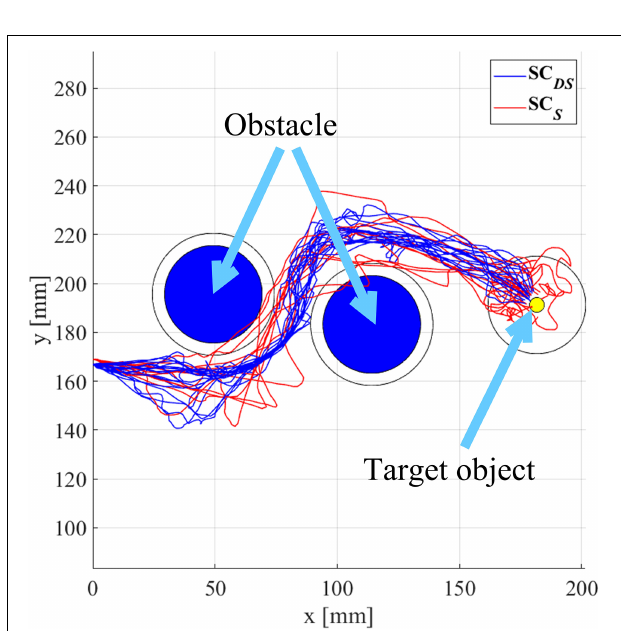
FIGURE 9 | Trajectories of the robotic arm end-effector in the horizontal plane during the reaching task with or without the direction shared controller (subject